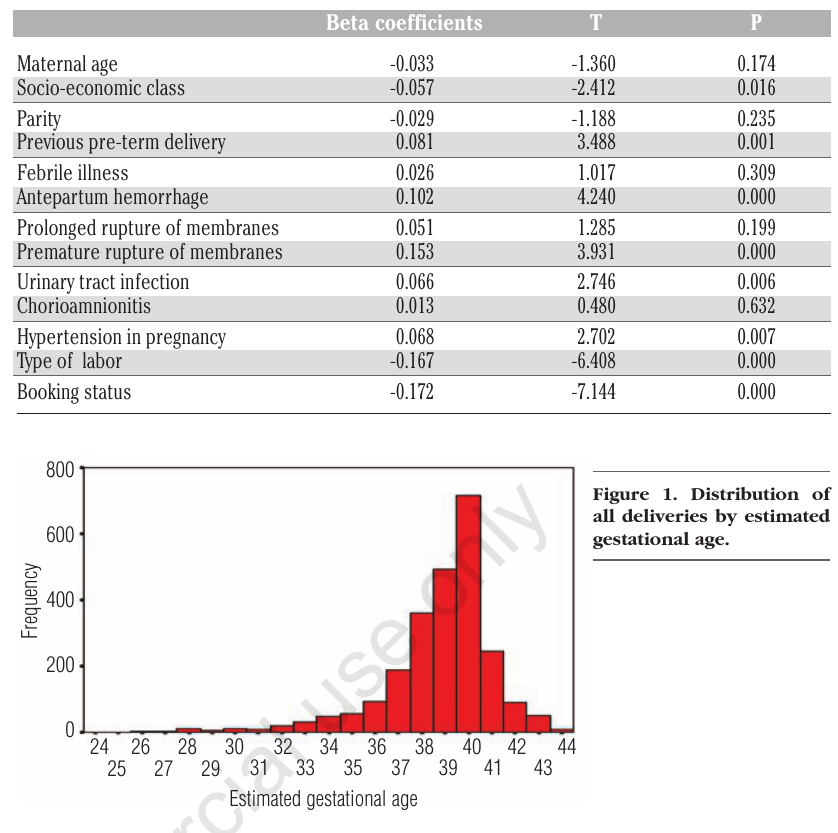
Table 3. Linear regression of maternal socio-demographic and antenatal variables on pre- term deliveries.